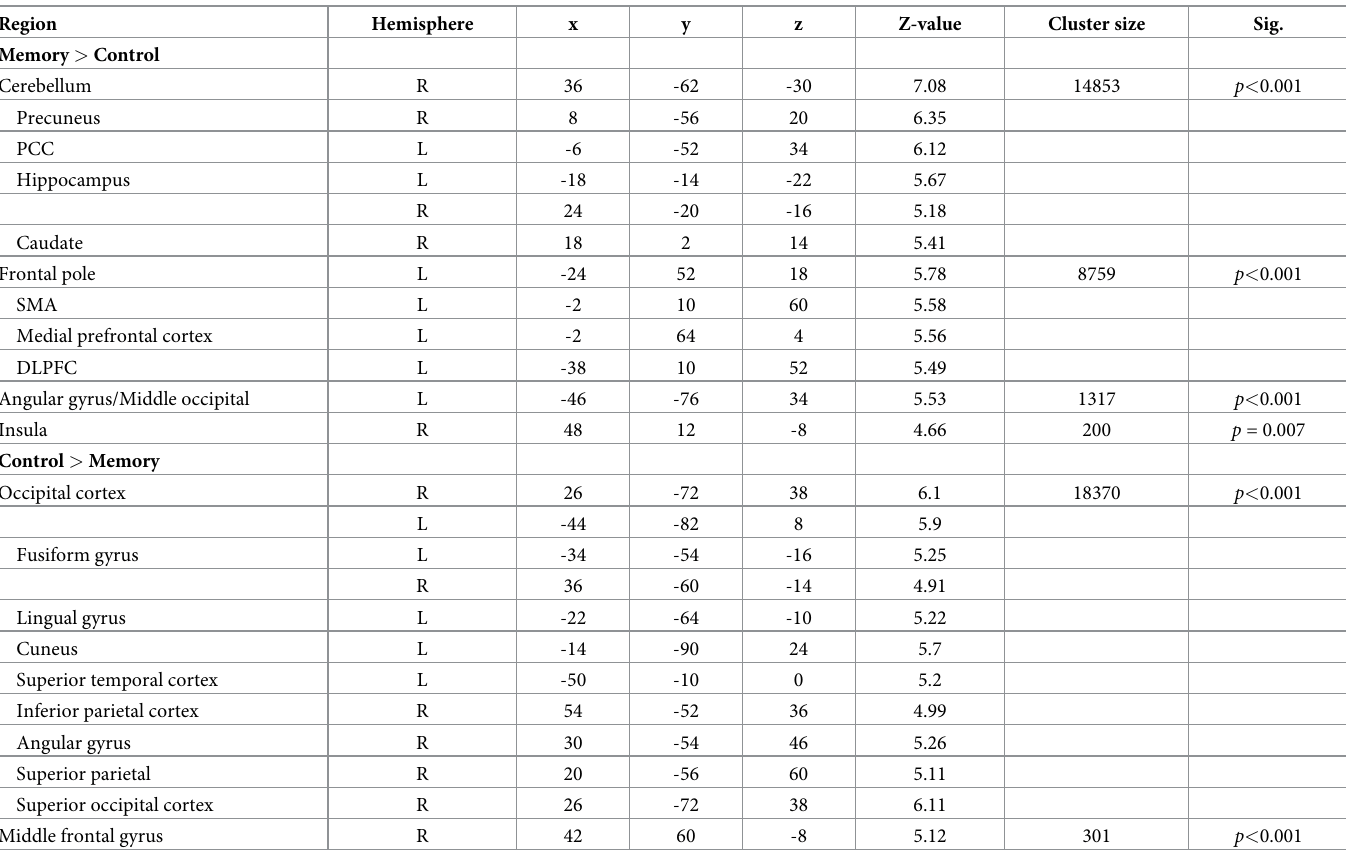
Table 2. Significant activation in the autobiographical memory task.